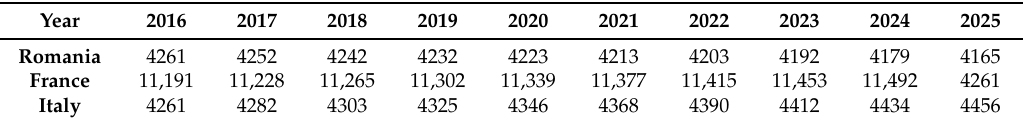
Table 3. Human consumption needs for cereals (thousand tones wheat equivalent). Source: authors’ own calculation based on [56].